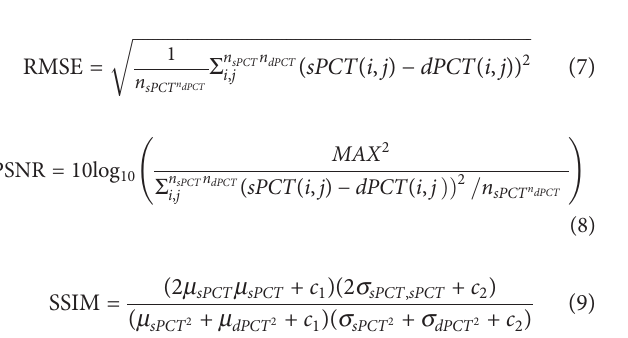
FIGURE 3 | Down-sampling part of U-net is used for the discriminators in CycleGAN. The input data size is 512 × 512 × 1, and the output data size is 32 × 32 × 1. The fi rst two digits represent the resolution, and the third digit represents the